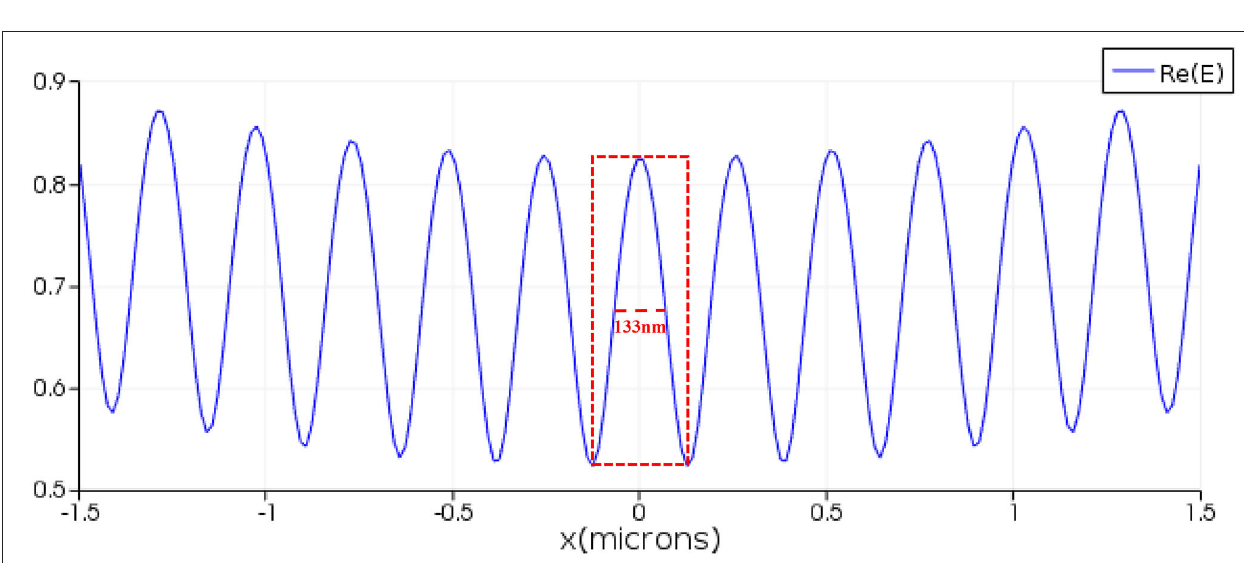
FIGURE 6 | The electromagnetic field distribution of the surface plasmon polariton (SPP) standing